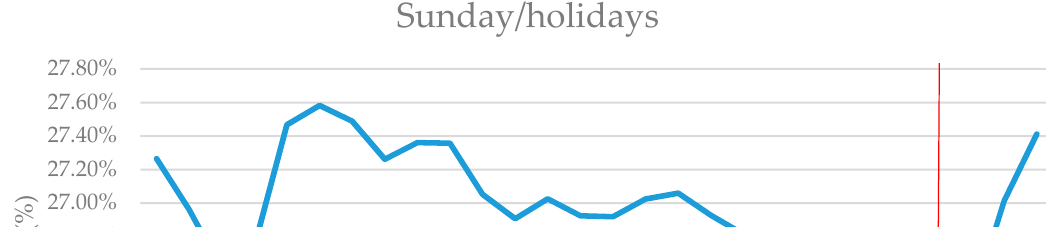
Table 3. Simulation results for electricity price forecast calculated with similar day method in 1st forecasting